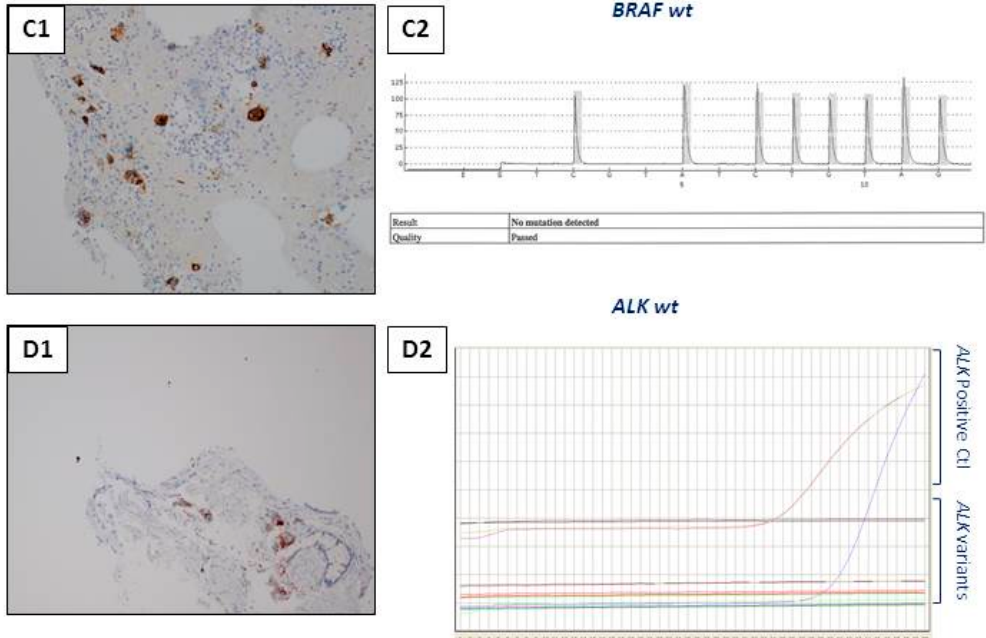
Figure 3. Examples of interest for use of IHC as a unique tool for theranostic biomarker detection in biopsies with a few tumor cells. ( A ) L858R EGFR mutation detection. ( A1 ) Positive EGFR IHC using the SP125 clone. ( A2 ) A negative molecular biology result (using a pyrosequencing/therascreen EGFR panel from Qiagen, Hilden, Germany) for detection of the L858R EGFR mutation with the same biopsy. ( B ) Detection of the Del 19 EGFR mutation. ( B1 ) Positive EGFR IHC using the SP111 clone. ( B2 ) A negative molecular biology result (using a pyrosequencing/therascreen EGFR panel from Qiagen, Hilden, Germany) for the Del 19 mutation in EGFR detected in the same biopsy. ( C ) Detection of the BRAF V600E mutation. ( C1 ) Positive BRAFV600E IHC using the VE1 clone. ( C2 ) A negative molecular biology result (using a pyrosequencing/therascreen BRAF panel from Qiagen) for detection of a BRAF mutation. ( D ) ALK status detection. ( D1 ) ALK status assessment. ( D1 ) A positive ALK IHC using the D5F3 clone. ( D2 ) A negative molecular result for detection of a ALK rearrangement [using RT-PCR targeting the variants 1 (E13; A20), 2 (E20; A20), 3A and 3B (E06; A20), 5 (E02; A20) and 7 (E17; A20) of ALK ].